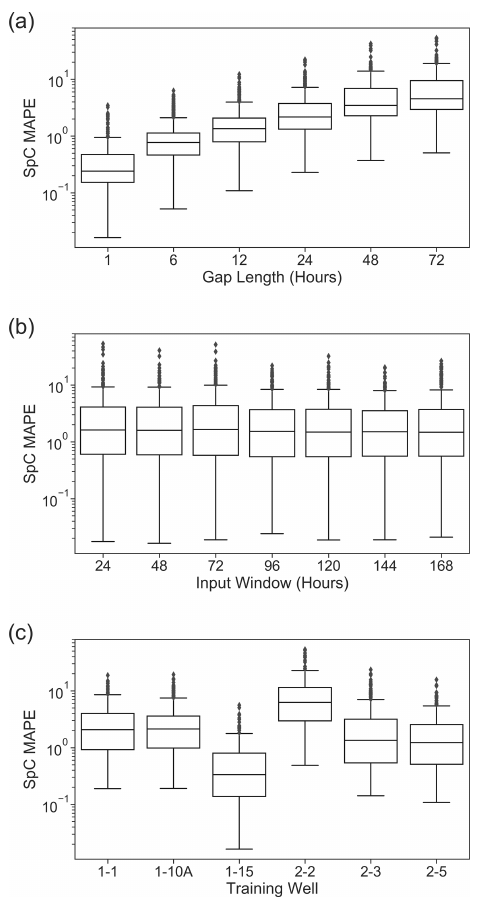
Figure 5. Gap-filling performance for SpC evaluated against the validation datasets, grouped by gap lengths (a) , model input win- dow size M (b) , and training wells (c)